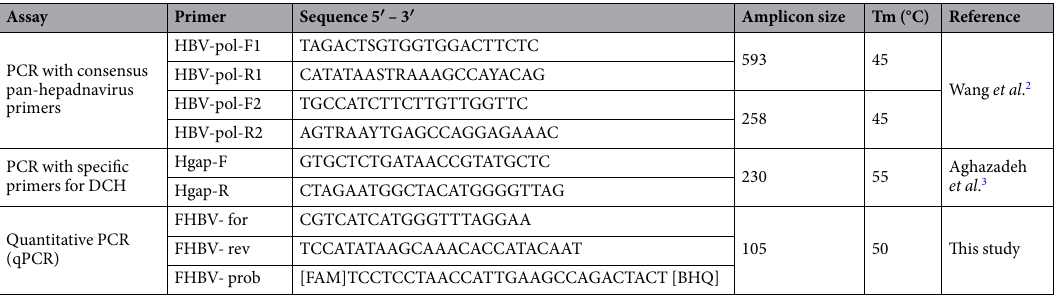
Table 2. Primer/probes used in this study.